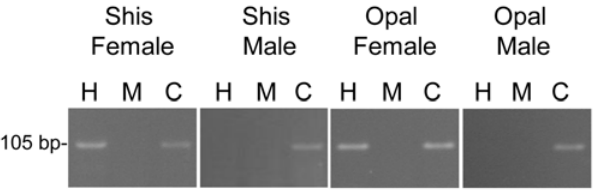
Figure 1. X-inactivation of the Zfx gene from S. hispidus (Shis) and O. palustris (Opal). Genomic DNA from female and male individuals was digested with either Hpa II (H, methylation sensitive), Msp I (M, methylation insensitive isoschizomer of Hpa II), or Bam HI (C, control with no Bam HI sites in the regions amplified). Subsequent PCR for a portion of the Zfx CpG island, followed by gel electrophoresis, resulted in the band seen above only if there was no restriction digestion within the amplified CpG island. The amplification of a CpG island PCR product in females after digestion with Hpa II shows that the island contains methylated CpGs, and therefore an inactivated gene. Absence of a product after Hpa II digestion in males shows that their CpG island is nonmethylated and therefore capable of activity. Msp